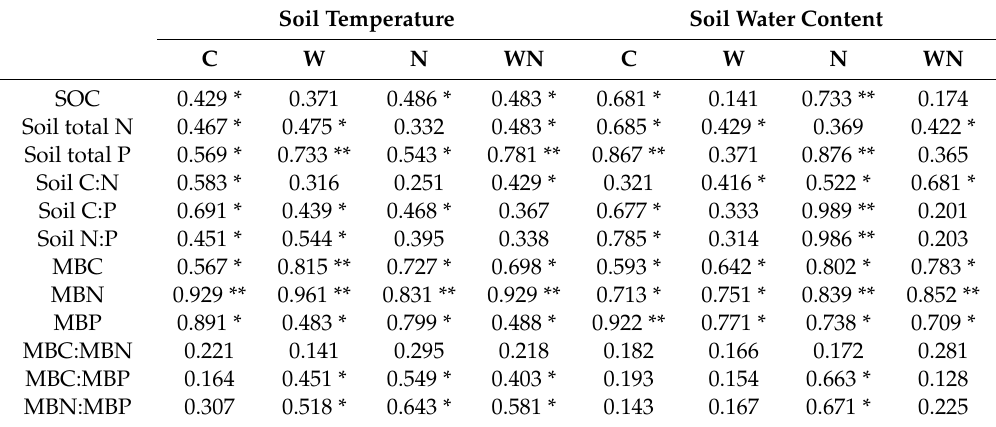
Table 1. Correlations between soil and SMB C, N, P and soil temperature as well as water content. Soil Temperature Soil Water